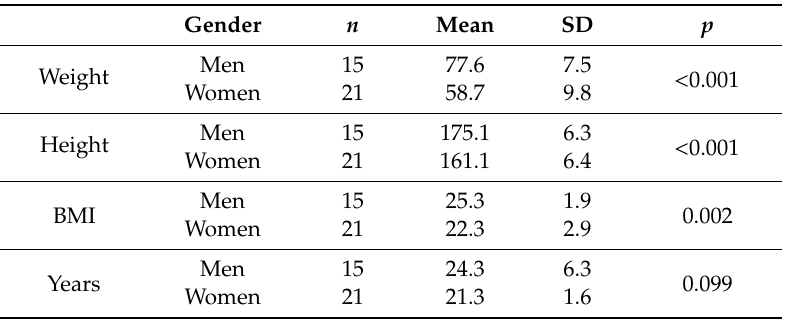
Table 1. Anthropometric data of the sample by